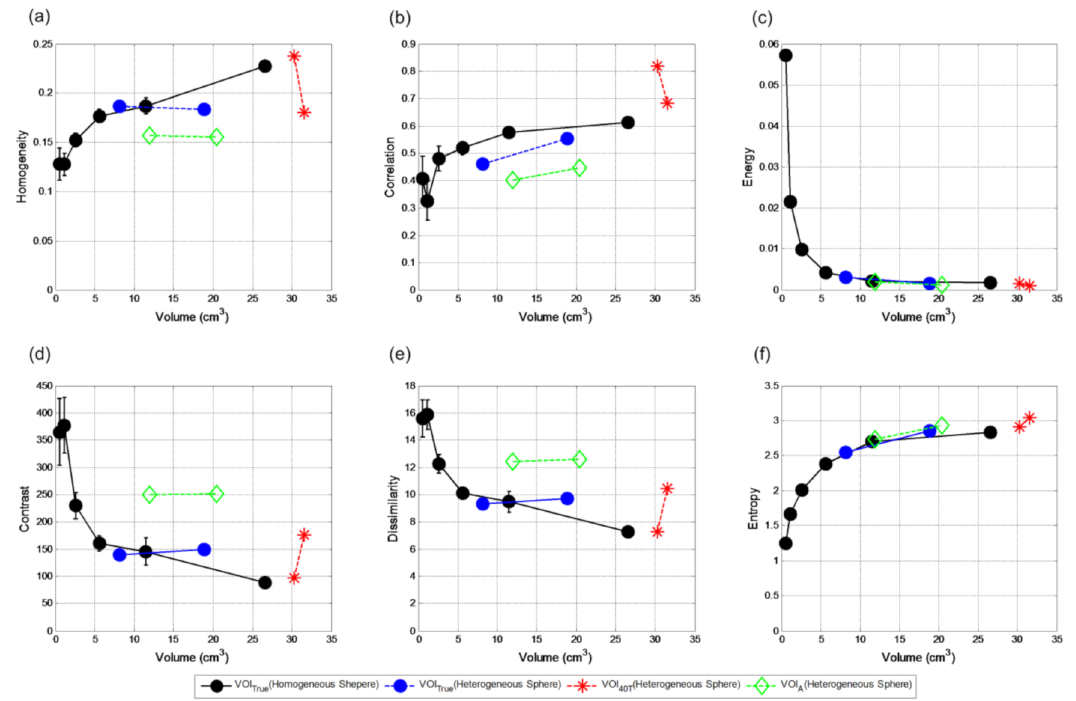
Figure 11. Six textural features vs. volumes for all six homogeneous spheres for VOI true and for two heterogeneous spheres for VOI true , VOI 40T , and VOI A . ( a ) Homogeneity, ( b ) contrast, ( c ) energy, ( d ) contrast, ( e ) dissimilarity and ( f ) entropy. Contrast and quantization level were kept fixed at 4:1 and 64